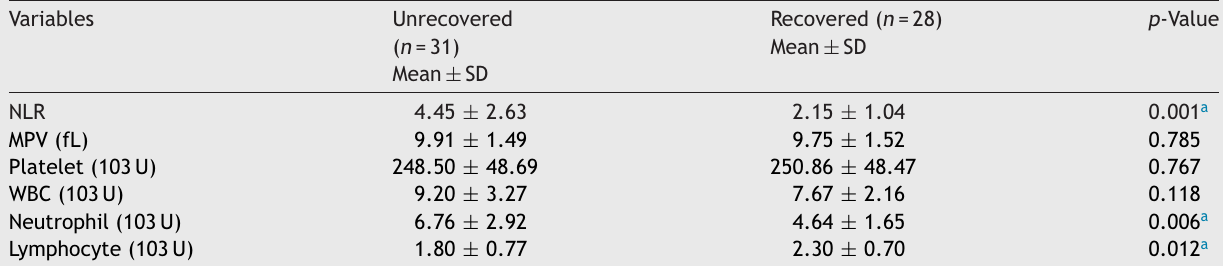
Comparison of laboratory data between the recovered and unrecovered patients.